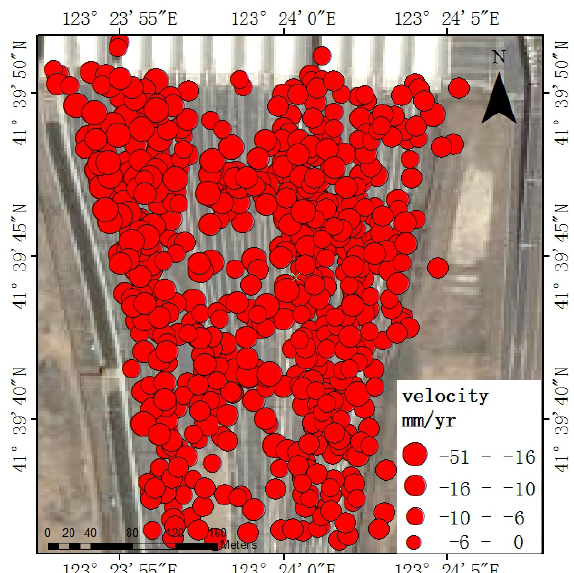
Figure.3(b) Subsidence pattern to the south of Shenyang South Railway Station in the eastern stack